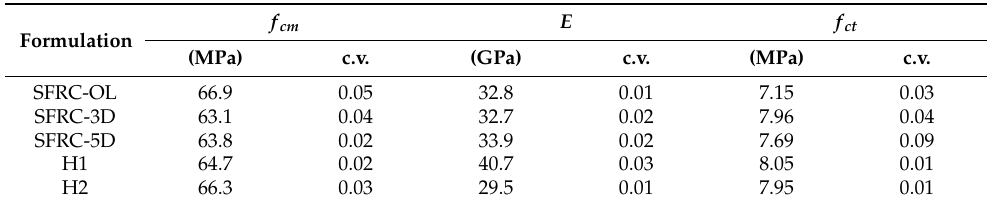
Table 3. Mechanical properties and their corresponding coefficient of variation (c.v.) of the concrete mixes [33].